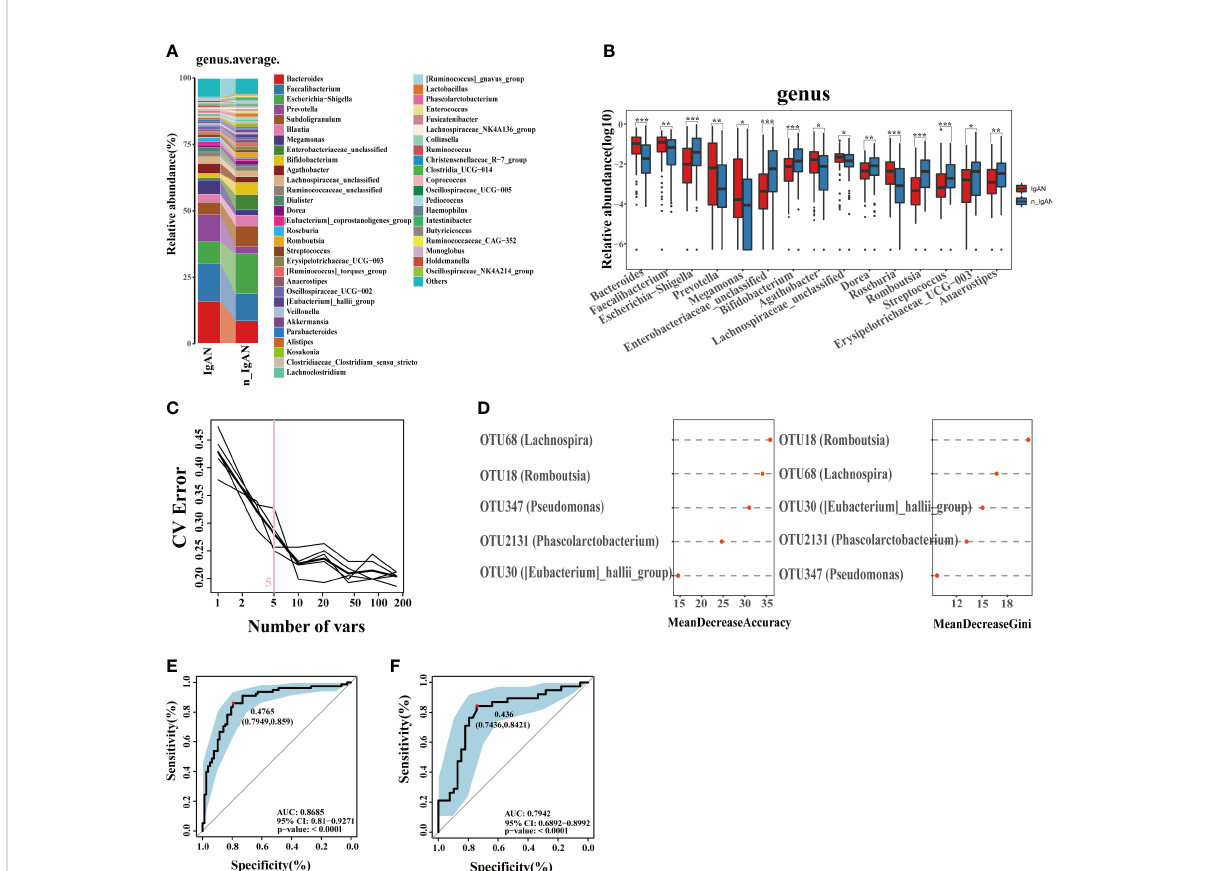
FIGURE 7 Phylogenetic pro fi les and differential diagnostic potential of gut microbes. (A) Comparison of microbial composition on genus level. (B) Comparison of differential microorganisms on genus level. Log 10 abundance of differential microorganisms on genus level (* P < 0.05; ** P < 0.01; *** P < 0.001). (C, D) Five microbial OTUs were fi nally determined as the optimal marker set for differential diagnose IgAN by the random forest model between IgAN and n_IgAN. The POD values of the training phase (E) and test phase (F) obtained AUC values of 0.8853 and 0.8448 respectively. CV, coef fi cient of variation; POD, probability of disease; CI, con fi dence interval; AUC, area under the